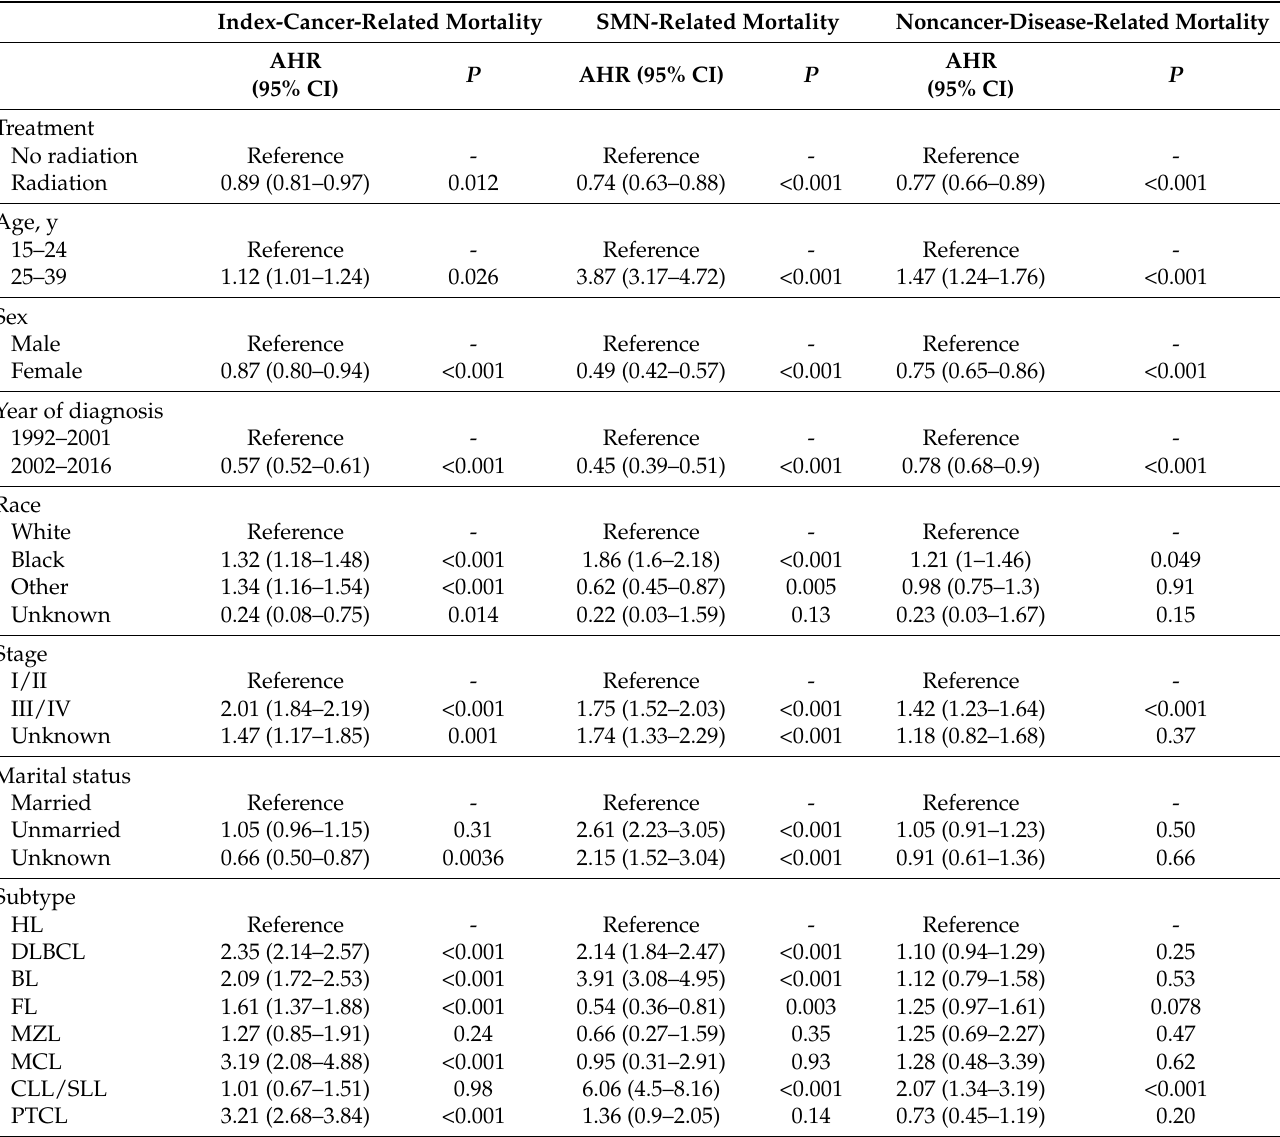
Table 2. Multivariable Fine–Gray regression modeling of predictors for index-cancer-related mortality, SMN-related mortality, and noncancer-disease-related